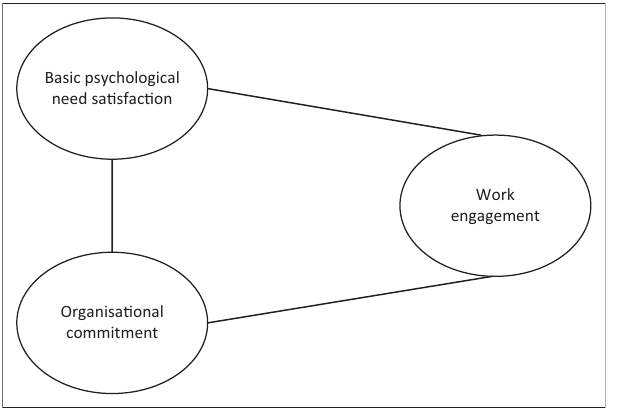
FIGURE 1: Theoretical relationship between basic psychological need satisfaction, organisational commitment and work engagement.